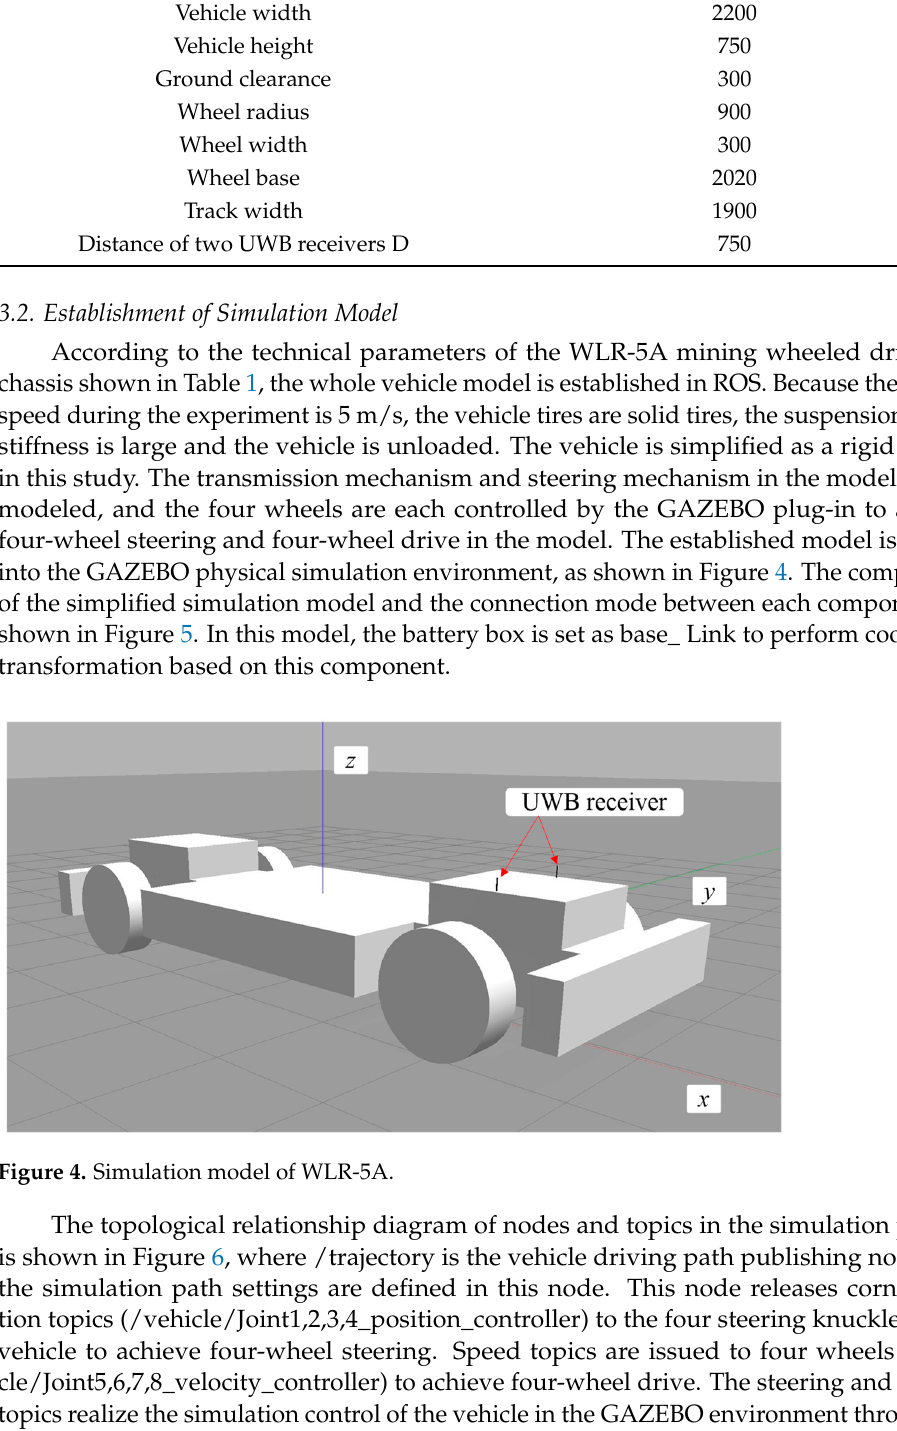
Figure 5. Link and joints relationship of simulation model.